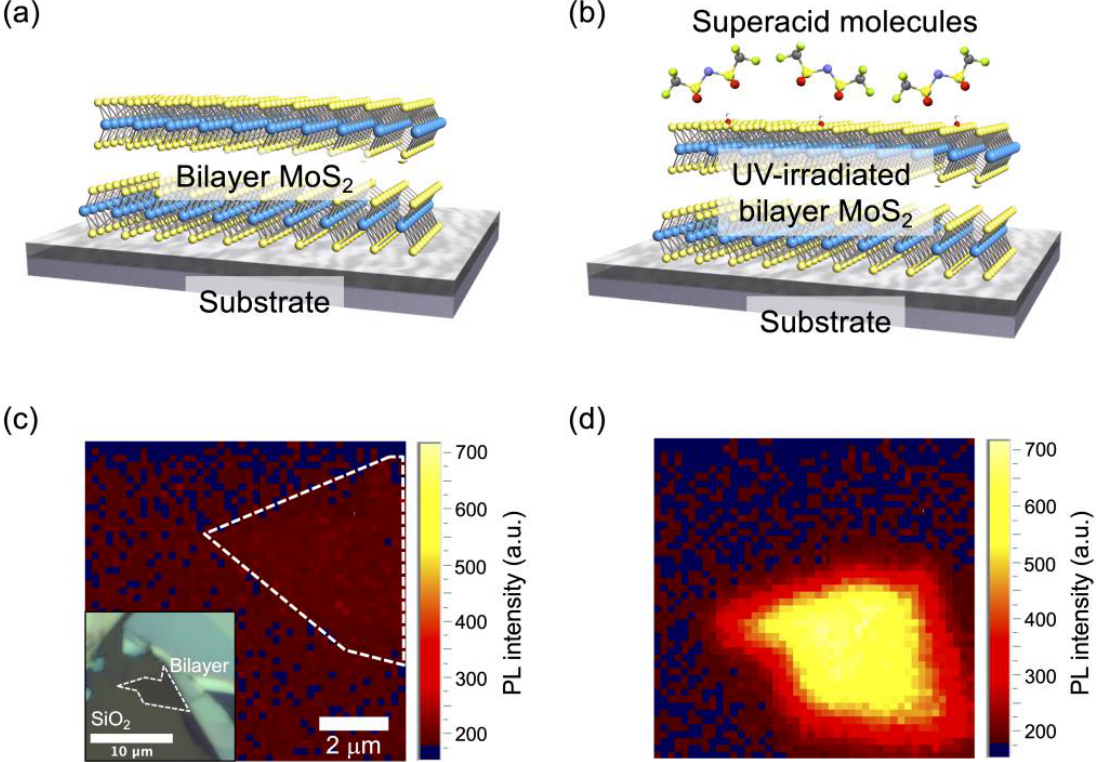
Figure 1. ( a , b ) Illustrative image of ( a ) the bilayer MoS 2 and ( b ) the bis(trifluoromethane)sulfonimide (TFSI) treatment for the UV-irradiated bilayer MoS 2 . ( c , d ) Photoluminescence (PL) mapping images for ( c ) the as-exfoliated bilayer MoS 2 and ( d ) the TFSI-treated sample for the UV-irradiated bilayer MoS 2 . The inset in Figure 1c is the optical microscope image for the targeted bilayer sample.